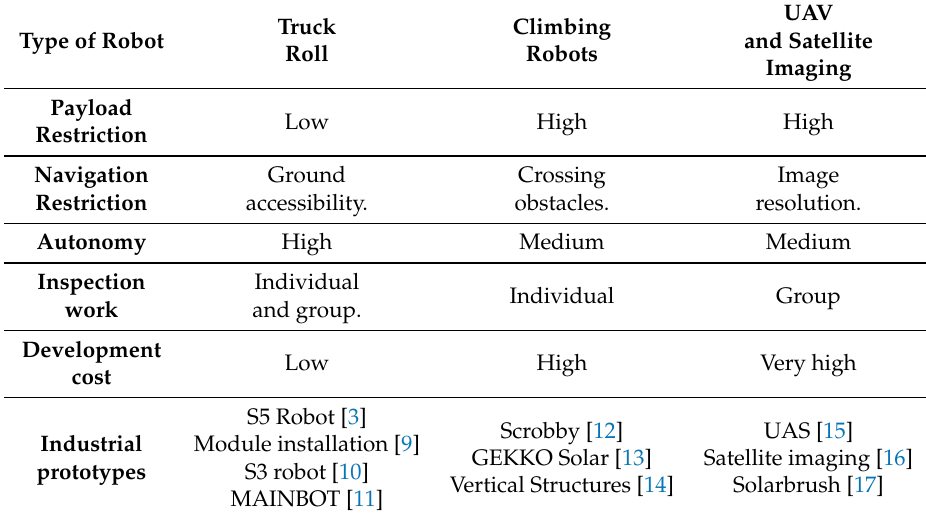
Table 1. Comparison of three main technologies used to perform inspection work in photovoltaic plants.